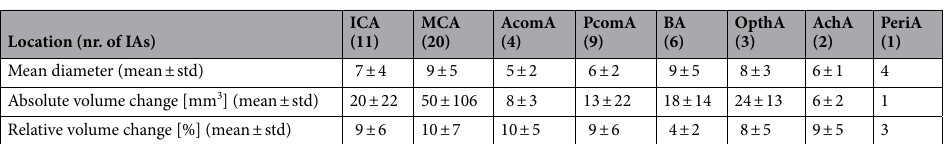
Table 5. Mean size, absolute and relative volume change per aneurysm location. ICA internal carotid artery, MCA middel cerebral artery, AcomA anterior communicating artery, PcomA posterior communicating artery, BA basilar artery, OpthA opthalamic artery, AchA anterior choroid artery, PeriA pericallosal artery.